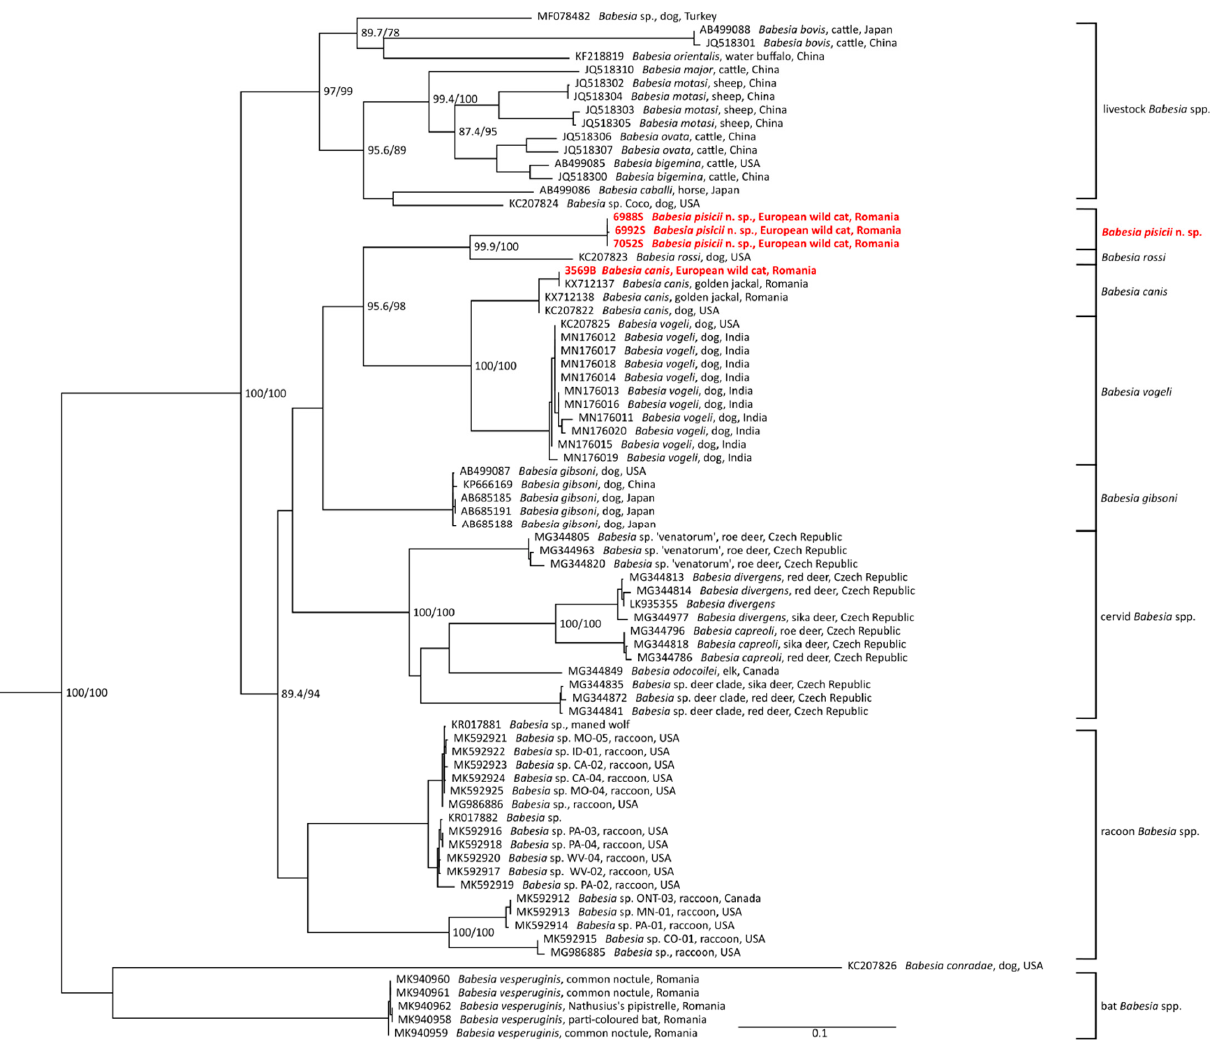
Figure 3. Phylogenetic tree assessed by maximum likelihood method based on COI sequences of Babesia sensu stricto species (clade X. sensu Jalovecká et al. [35]) and sequences obtained during the current study (highlighted in red); bootstrap values (SH-aLRT/UFB) above the threshold 80/95 are displayed. The scale bar indicates the number of nucleotide substitutions per site.